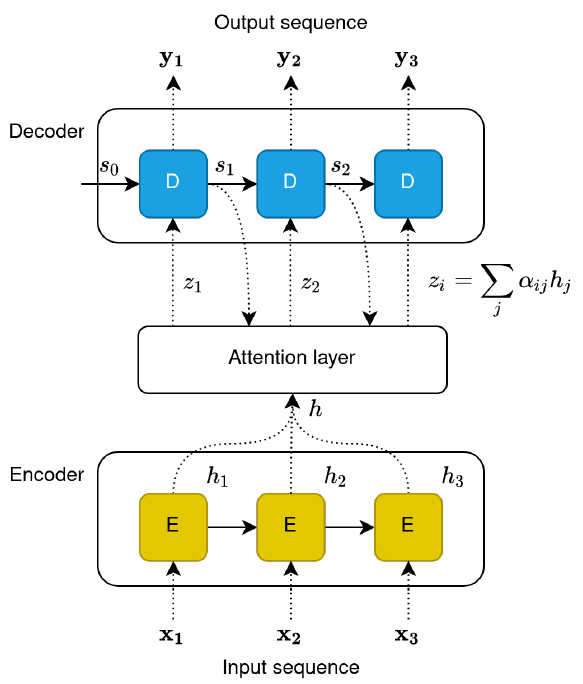
Figure 4. Unfolding of encoder–decoder architecture with attention